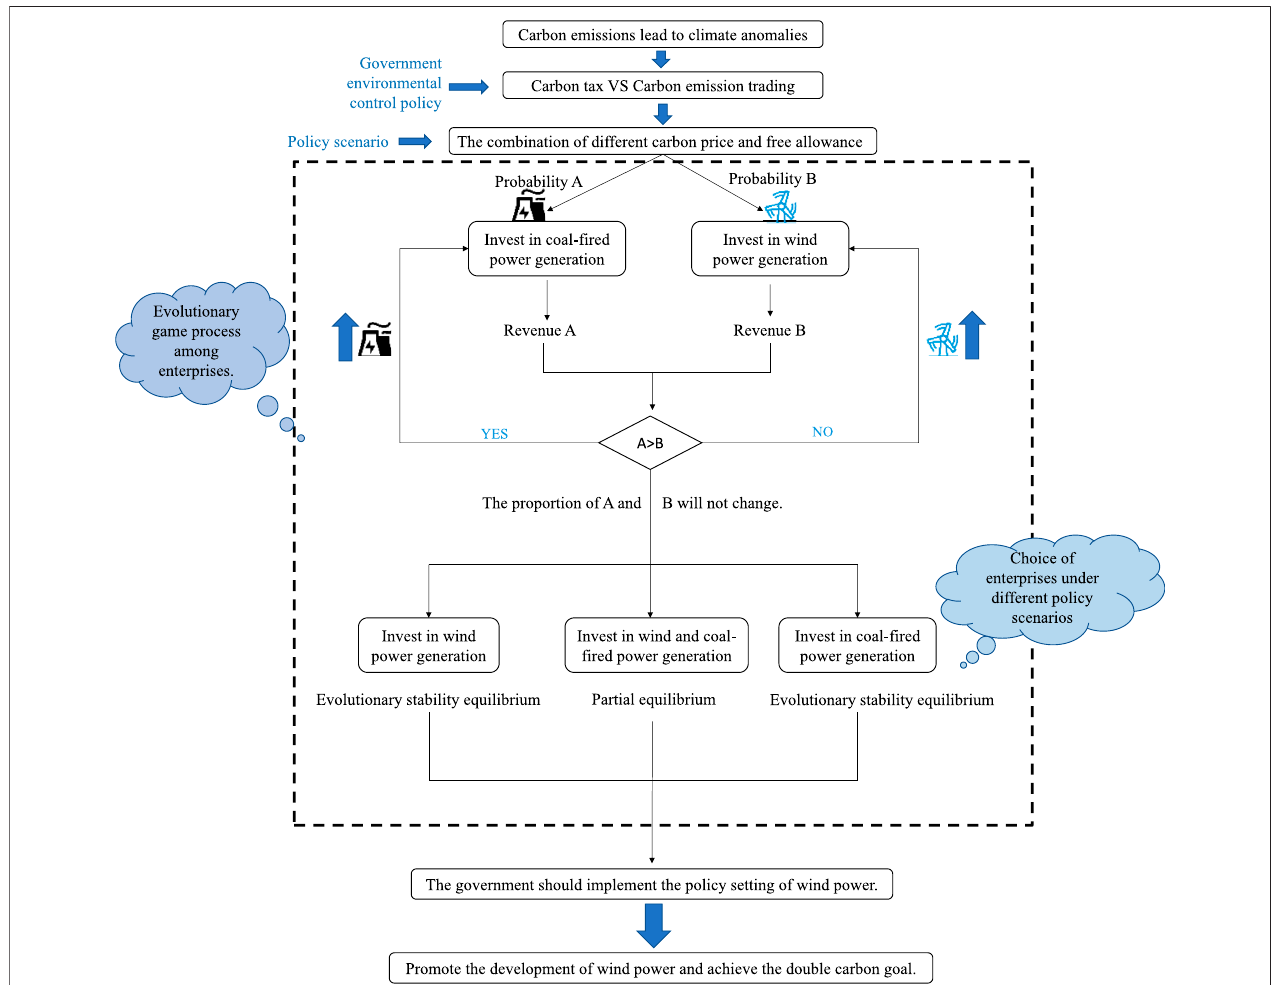
FIGURE 1 | The framework of evolutionary game theory for an investment